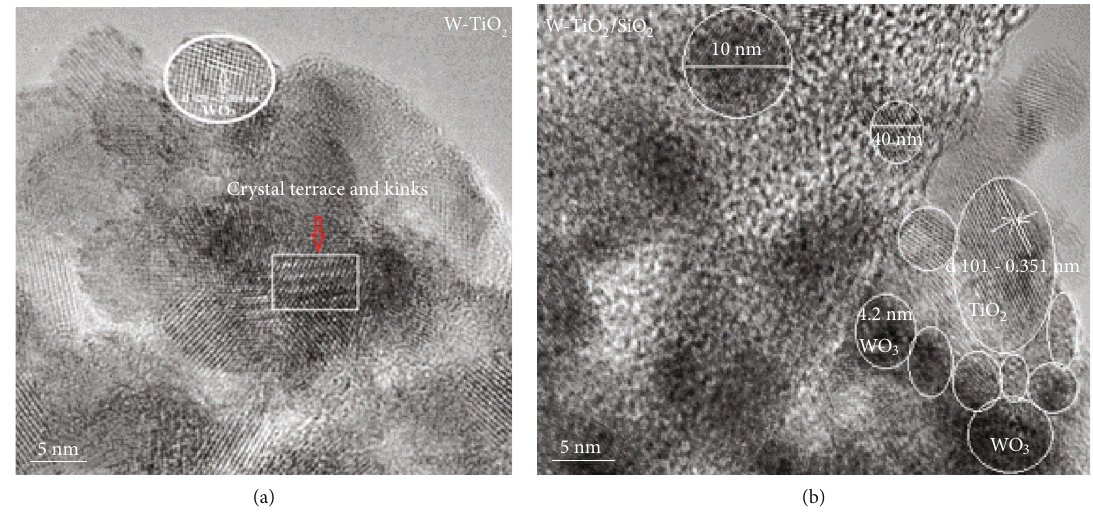
Figure 5: TEM micrographs of the W-TiO